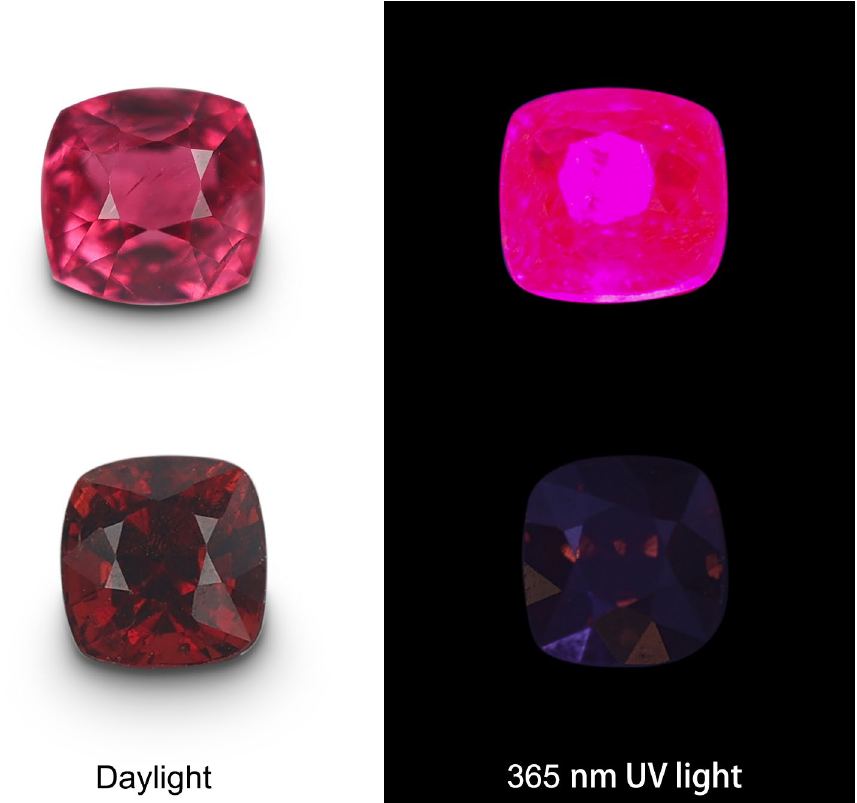
Figure 9. Pinkish-red and dark-red faceted spinel under daylight and 365 nm UV